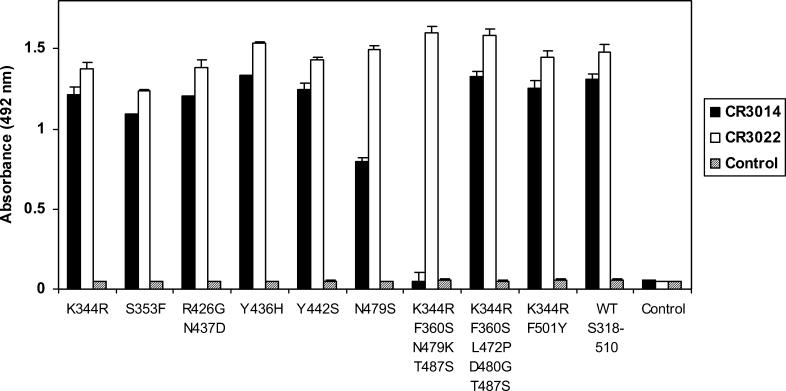
Binding of Human mAbs to S318–510 Fragments in ELISAWild-type and variant fragments were synthesized according to published sequences of SARS-CoV strains. Wild-type S318–510 from strain Frankfurt 1, variant fragments from strains GZ02 (K344R), Sin3408 (S353F), Shanghai LY (R426G and N437D), GZ-C (Y436H), Sino1–11 (Y442S), BJ302 cl. 2 (N479S), SZ3 (K344R, F360S, N479K, and T487S), GD03T0013 (K344R, F360S, L472P, D480G, and T487S), and GD01 (K344R and F501Y). Bars represent the means ± standard deviation.